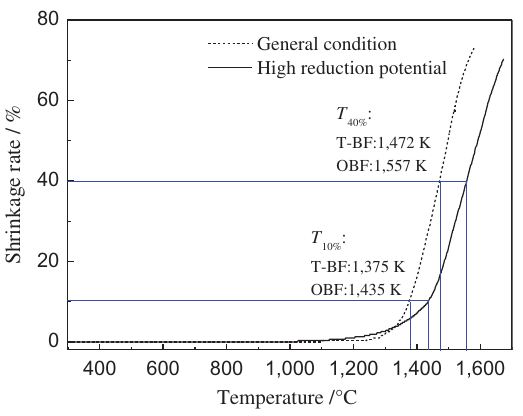
Figure 9: Shrinkage rate – temperature curve of sinter in general condition and high reduction potential condition.